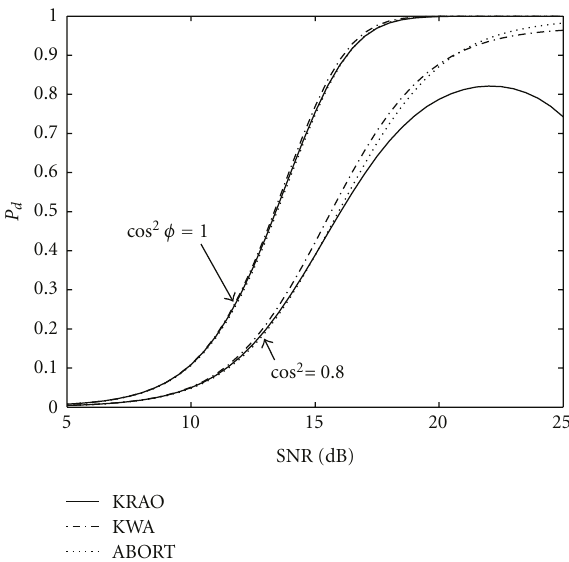
Figure 5: P d versus SNR for the KRAO with ρ = 0 . 7, the KWA with γ = 0 . 6, and the ABORT, N = 16, K =